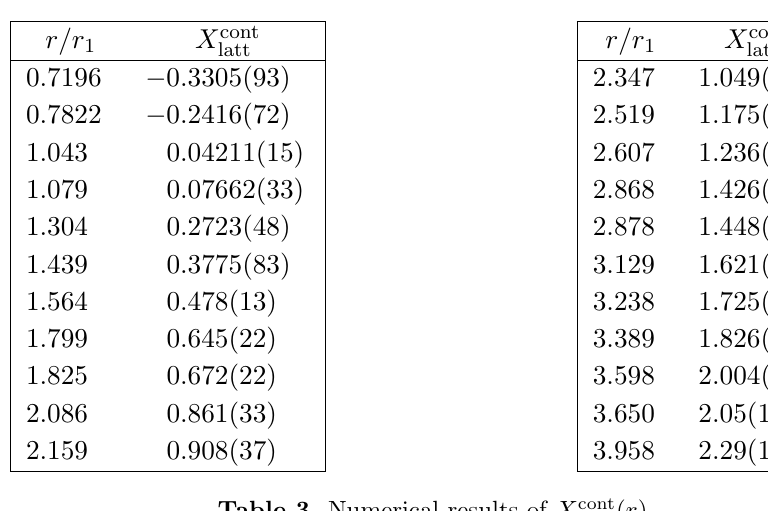
Figure 6 . Continuum limit of the lattice result, X cont ones from d = 2.